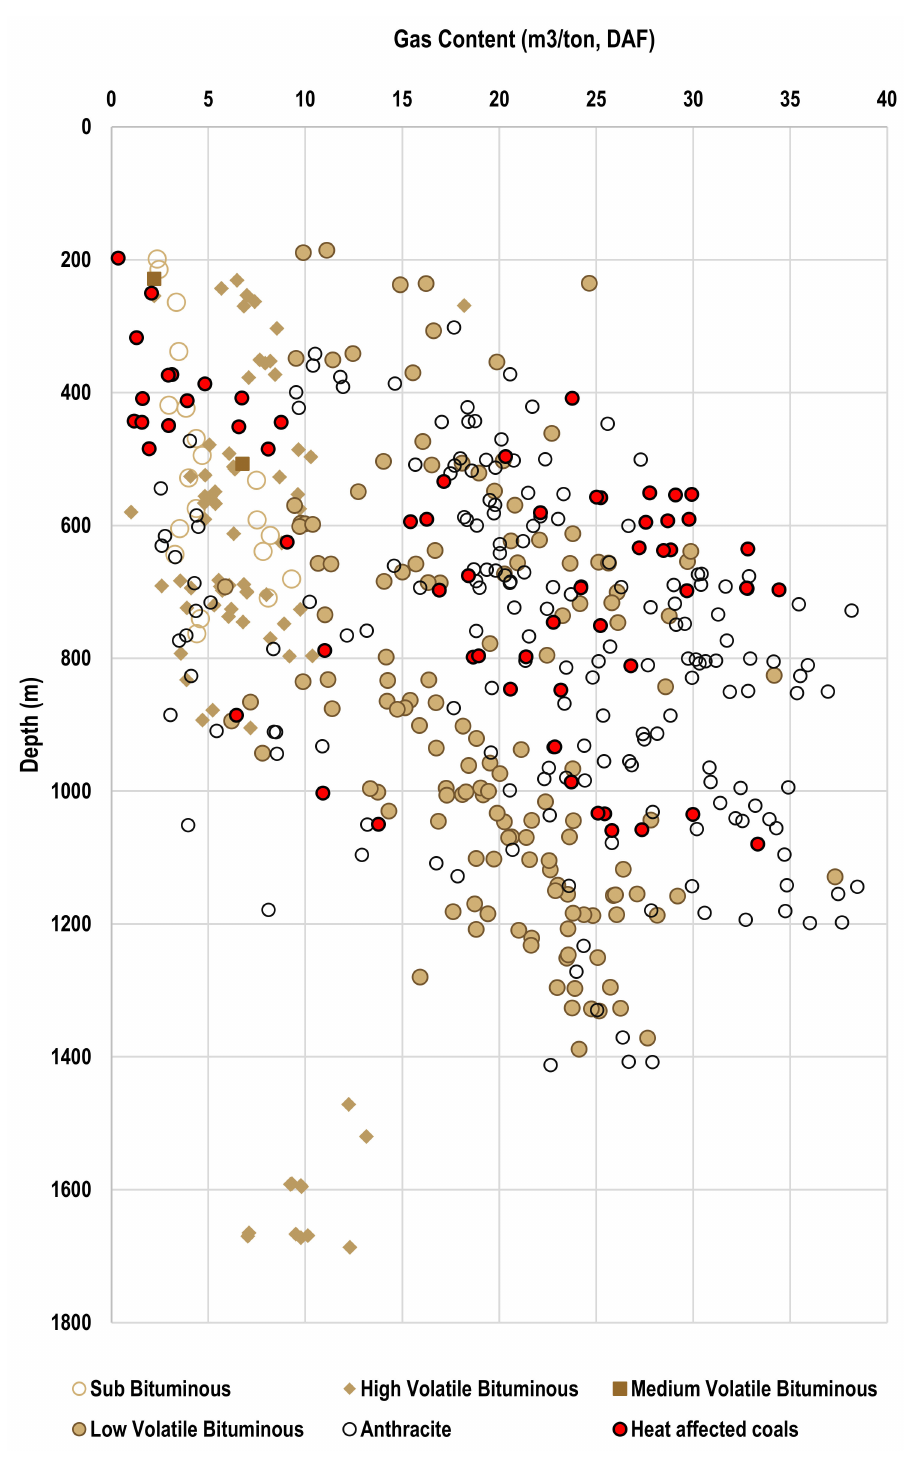
Figure 8. Gas content versus depth measured in 28 CSG core wells in the Bowen Basin. Coal rank is also shown, and heat affected coals are highlighted (data sourced from Queensland Government